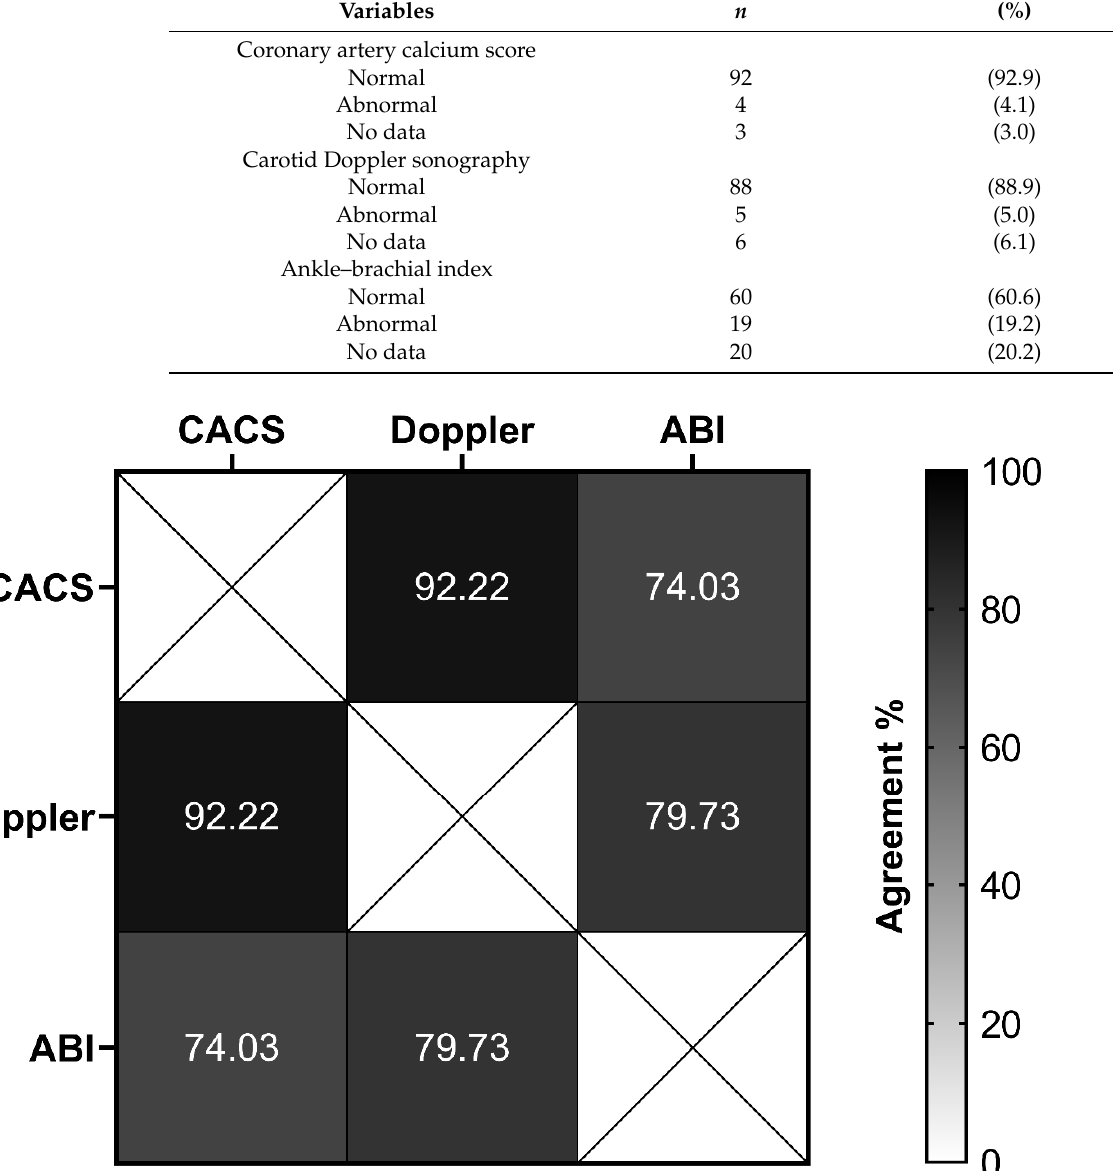
Table 2. Distribution of early markers of cardiovascular disease in the type 1 diabetes patients.